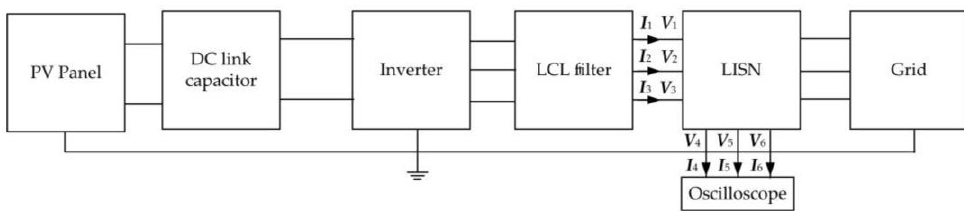
Figure 6. Measurement setup exploited to evaluate the active part of the black-box model, i.e., the three current sources I S1 , I S2 and I S3 .